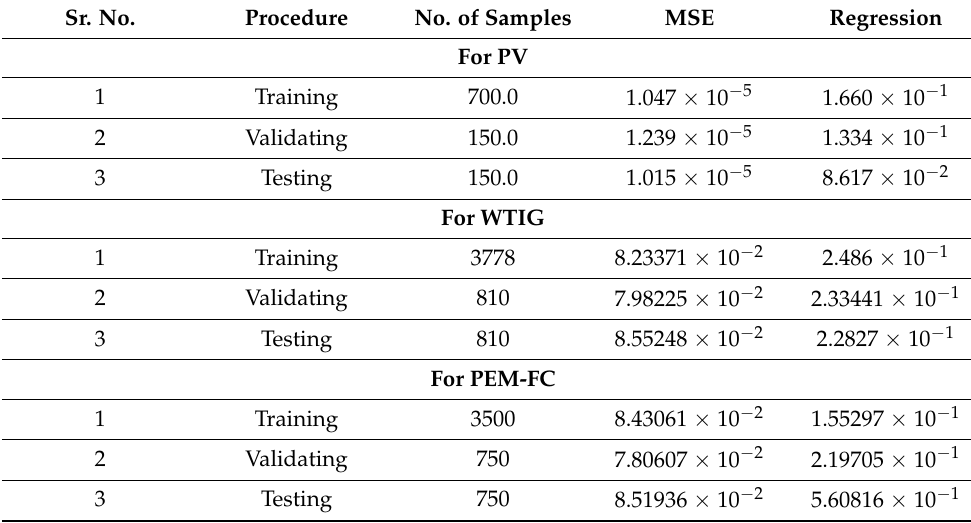
Table 10. Process of MSE and Regression for Training, Validation and Testing. Sr.